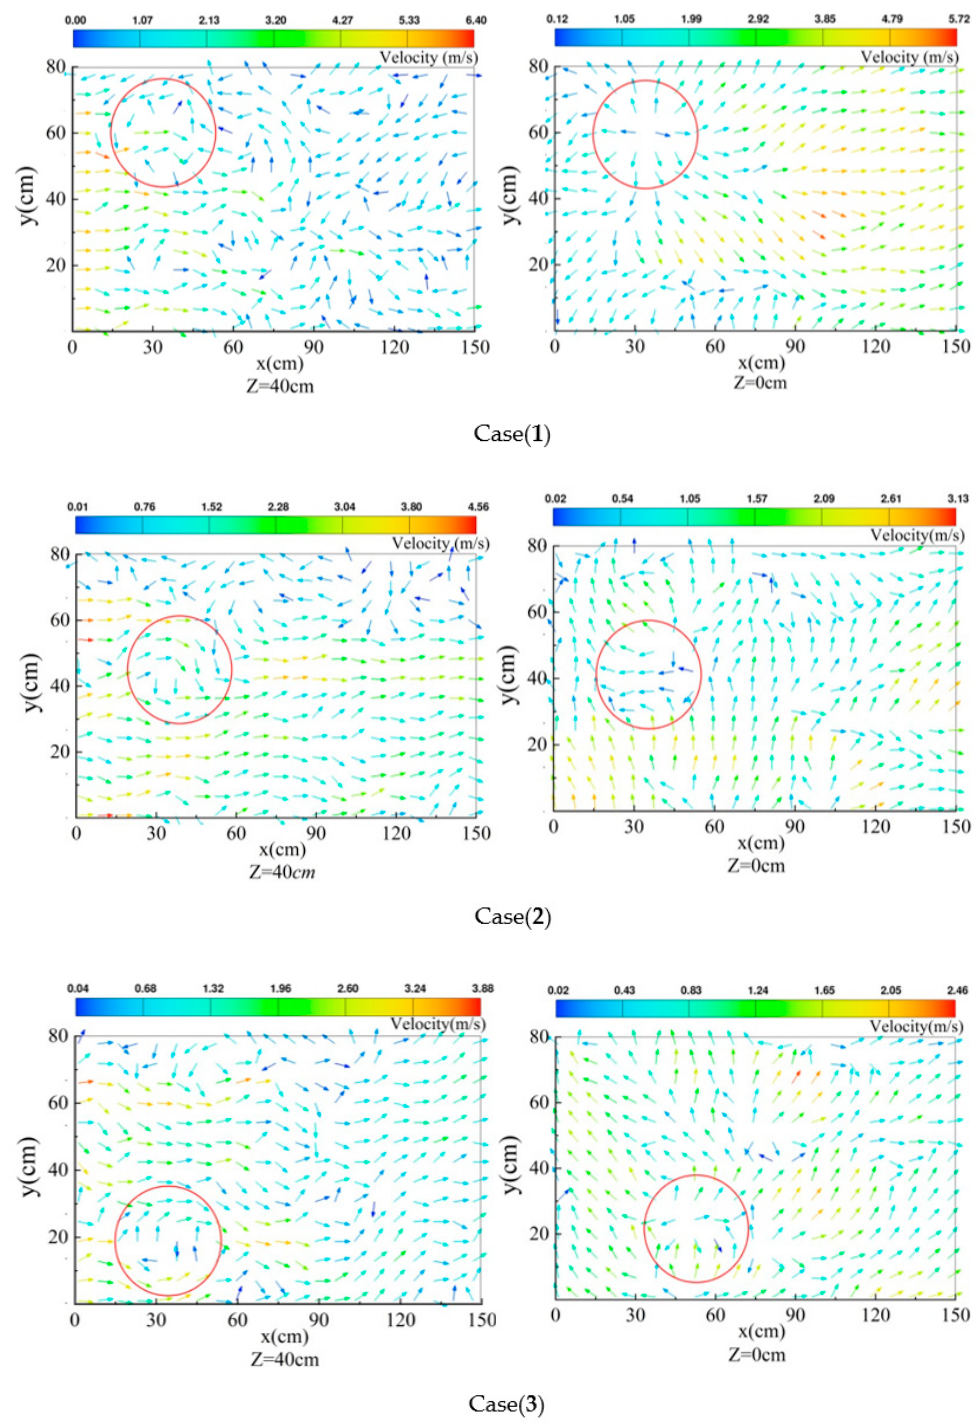
Figure 10. Speed vector in stilling basin at z = 40 cm horizontal plane and bottom plate plane in three cases. three